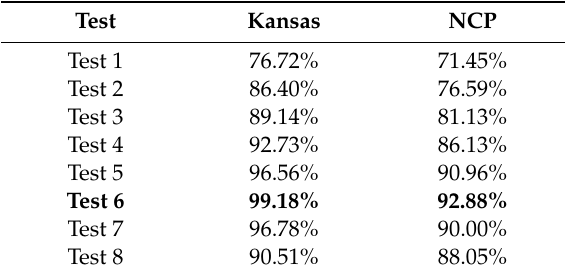
Table 7. The accuracies of the sensitivity study.